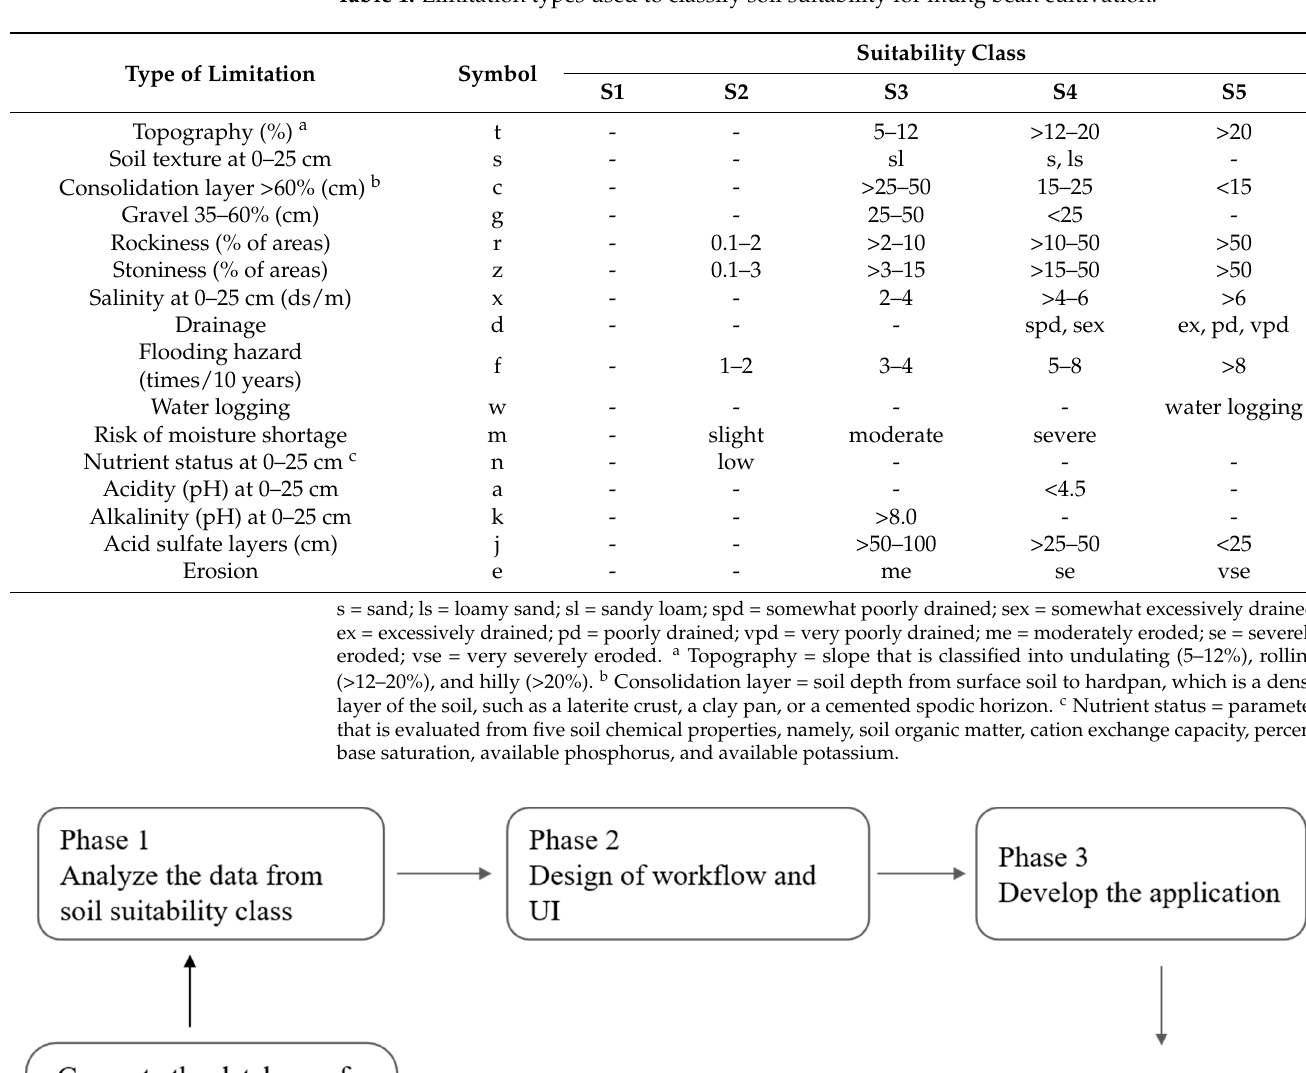
Table 1. Limitation types used to classify soil suitability for mung bean cultivation.